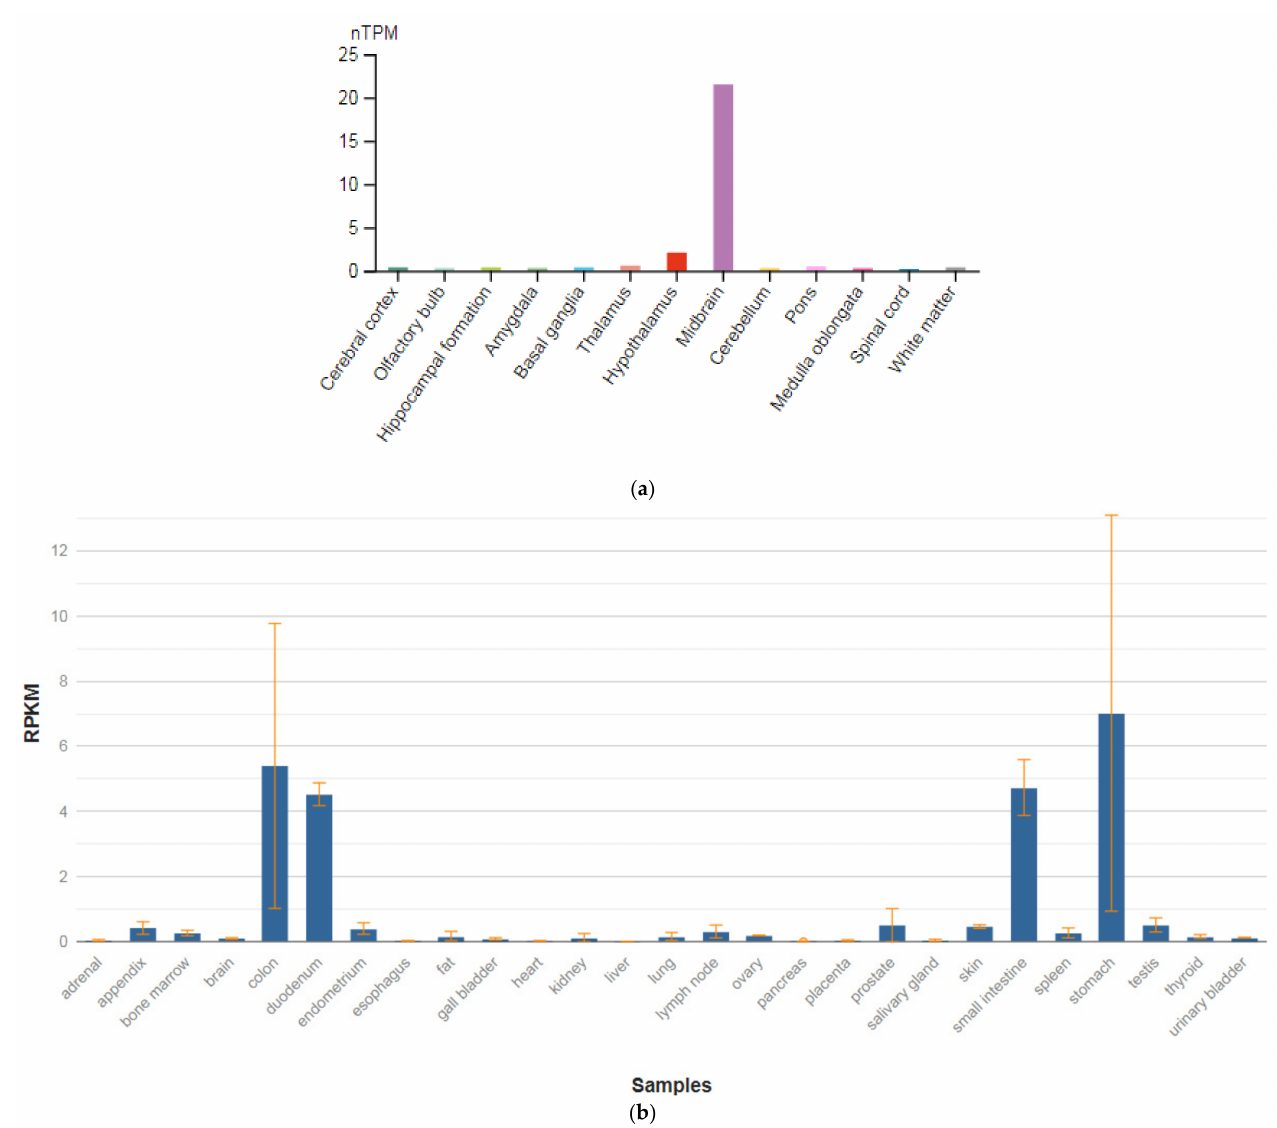
Figure 5. The tissue expression of tryptophan hydroxylase type 1 in the brain ( a ) and other organs in the human body ( b